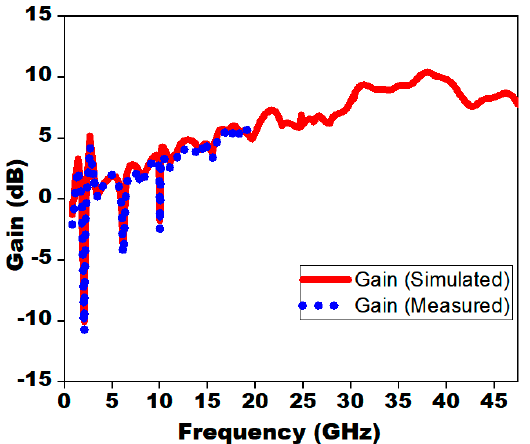
Figure 12. Three-dimensional polar gain plot for the designed antenna at notch frequency ( a ) 2 GHz, ( b ) 6 GHz, and ( c ) 10 GHz.